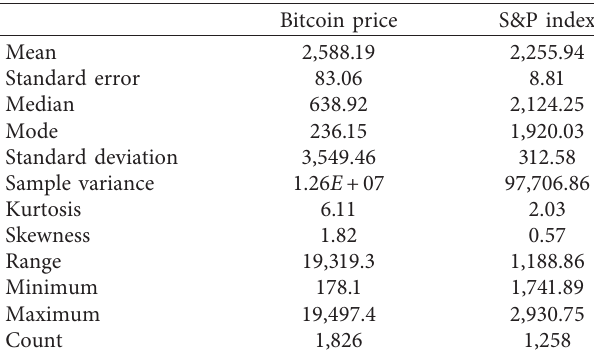
Table 1: Descriptive statistics for the bitcoin price and S&P